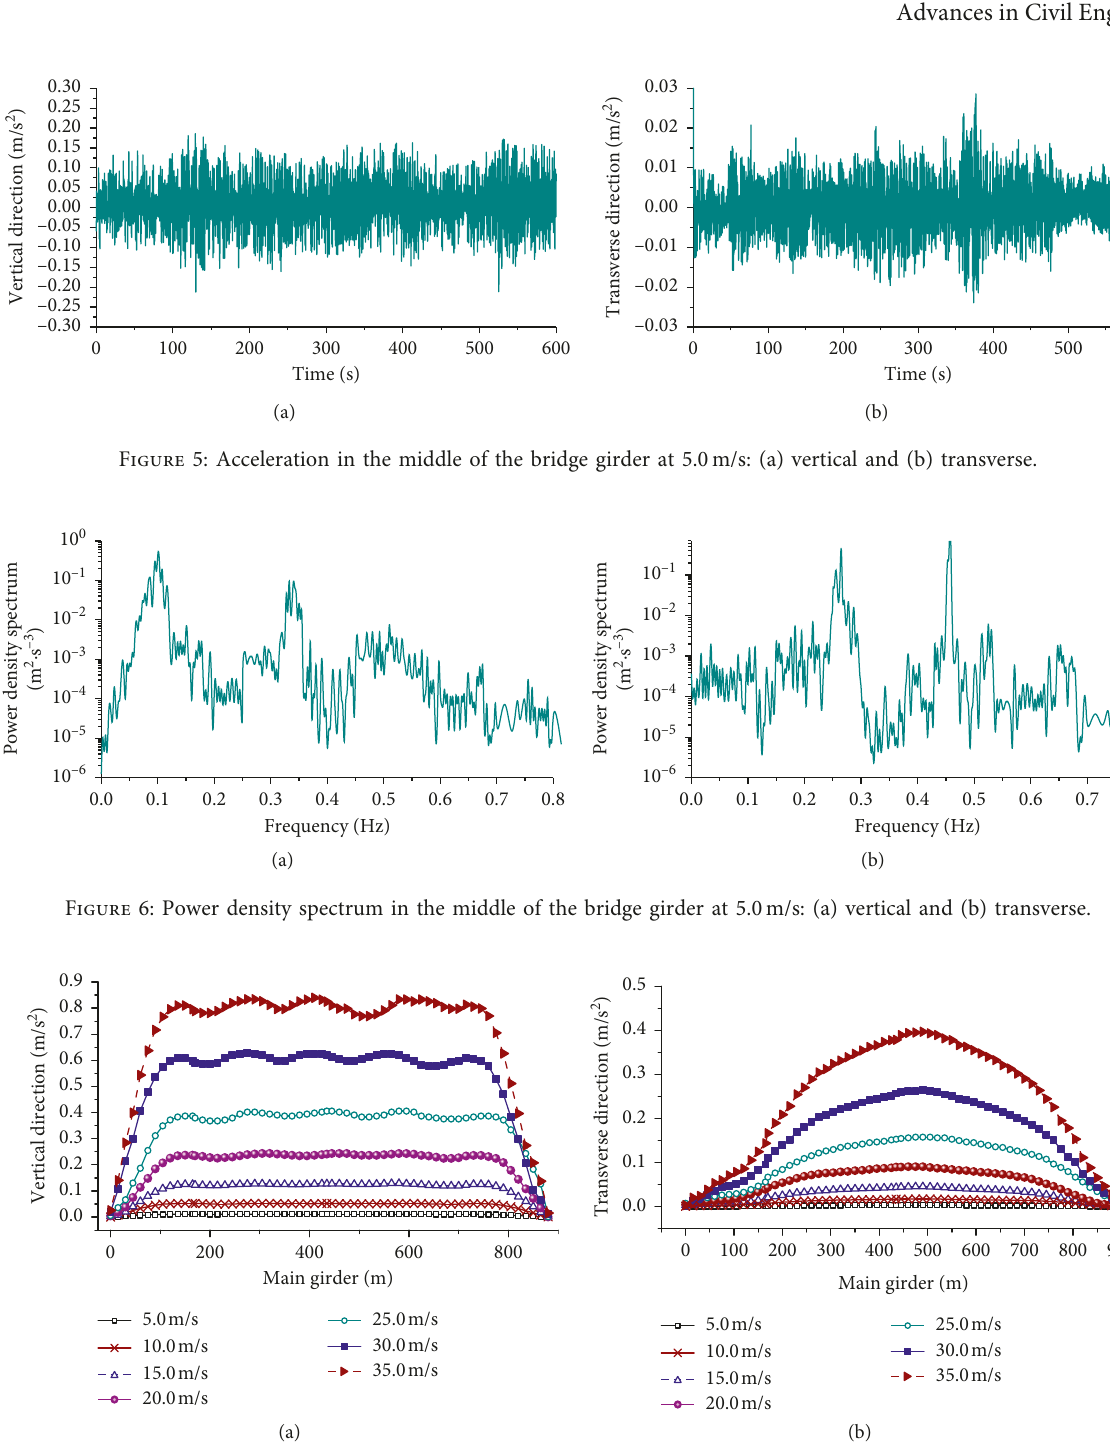
Figure 7: Acceleration along the main girder at different wind velocities: (a) vertical and (b)